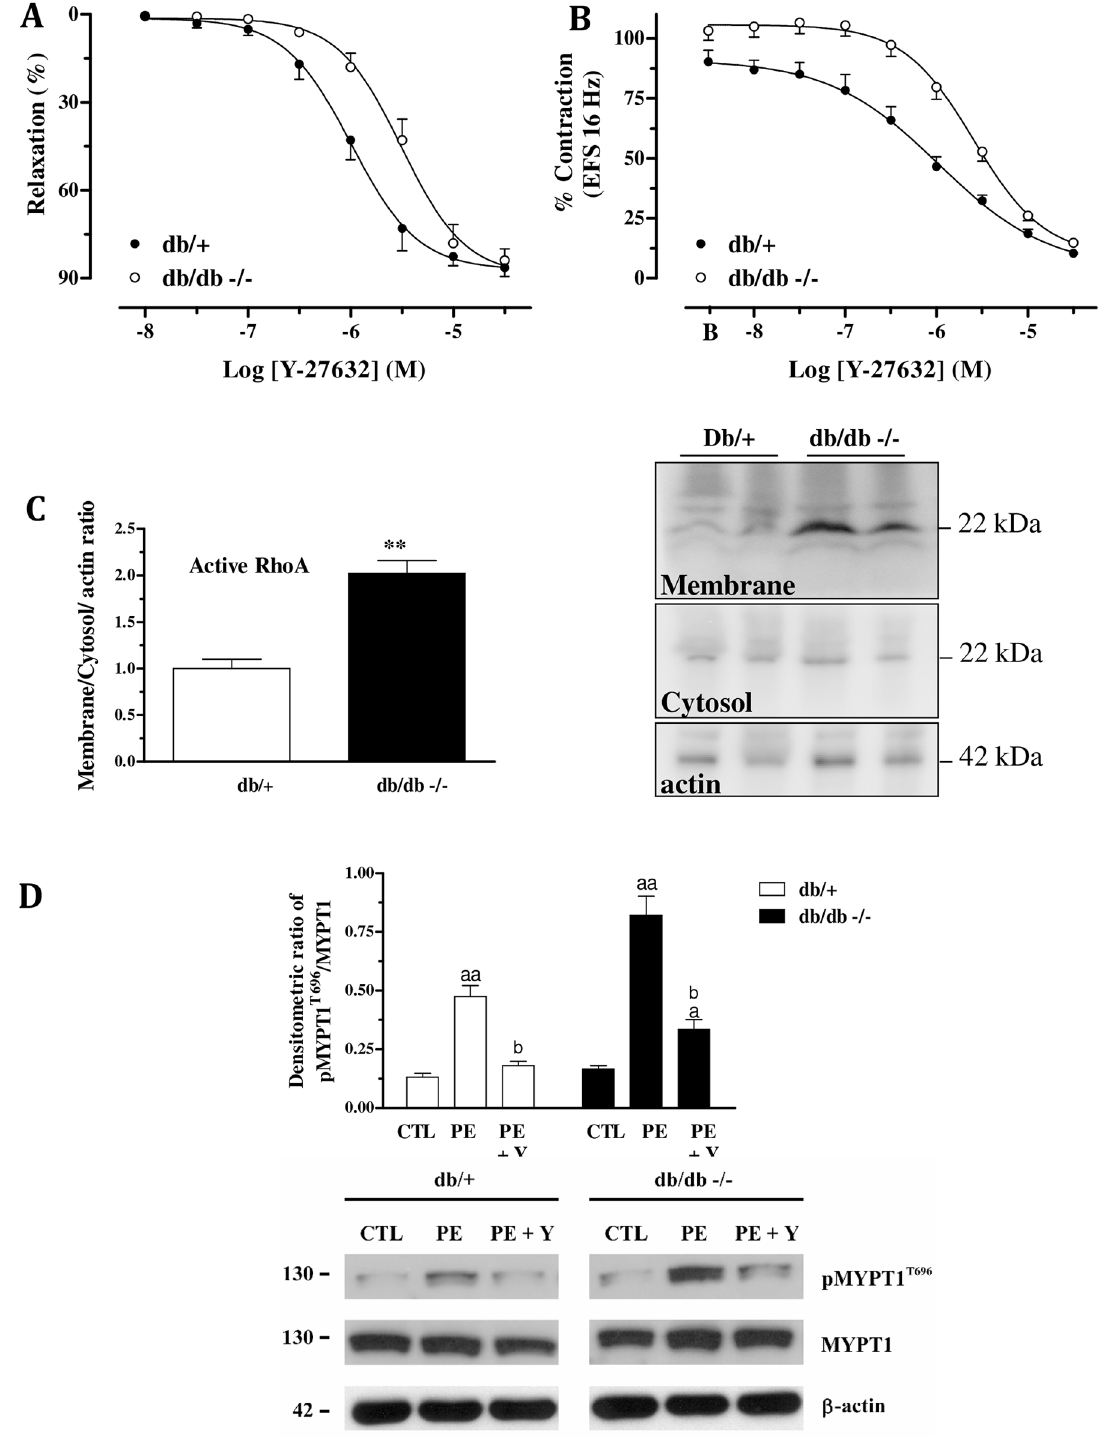
Fig 1. A) Relaxation response induced by the Rho-kinase inhibitor, Y-27632, in cavernosal tissue of db/+ and db/db mice pre- contracted with phenylephrine (PE 10 μ mol/l); B) Inhibition of the electrical field stimulation-induced contraction in the absence (B) or in the presence of increasing concentrations of Y-27632 (EFS 16 Hz; Y-27632 0.01 – 30 μ mol/l). C) Protein expression of RhoA in the corpora cavernosa of db/+ and db/db mice. Increased levels of active RhoA (membrane fraction) were observed in db/db compared db/+ mice. Densitometry values were normalized to β -actin and expressed as the fold increase of